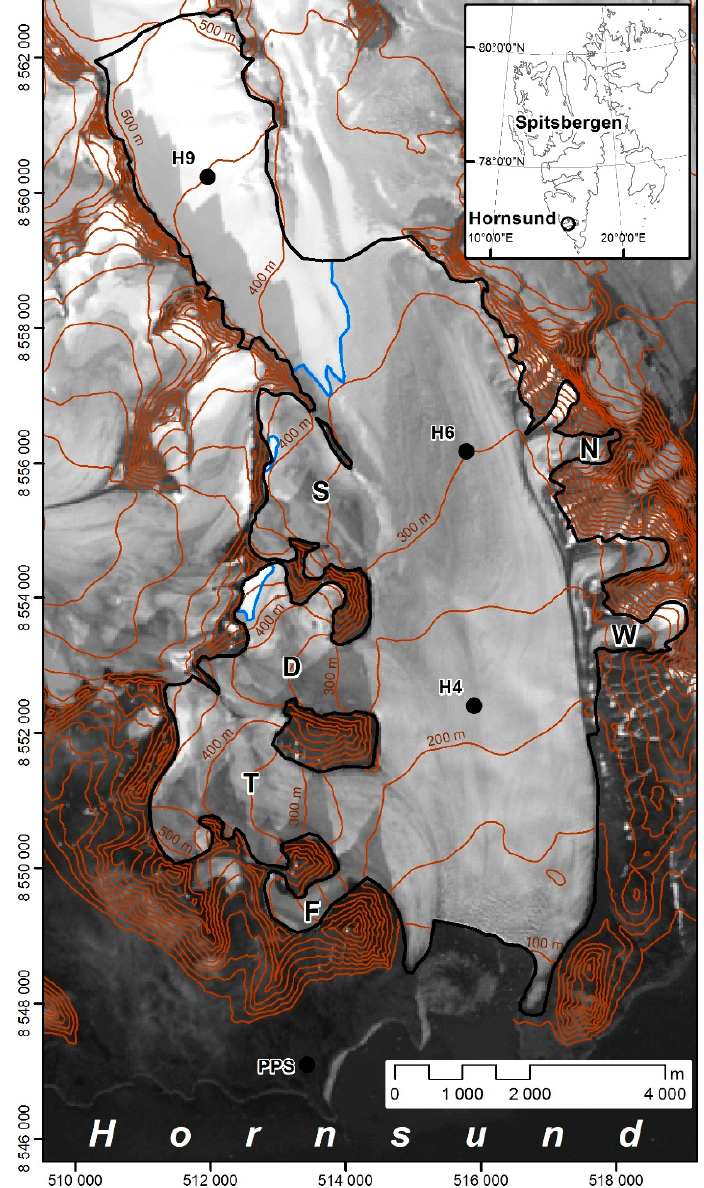
Figure 1. Study area and location of the meteorological station at the Polish Polar Station Hornsund (PPS) and automatic weather stations and mass balance stakes on Hansbreen (H4, H6, H9) on the background of LandSat on 26.09.2015. Blue line, snow line on 26.09.2016; capital letters, tributary glaciers: D, Deileggbreen; F, Fuglebreen; N, Nordstebreen; S, Staszelisen; T, Tuvbreen; and W, Wienerbreen.